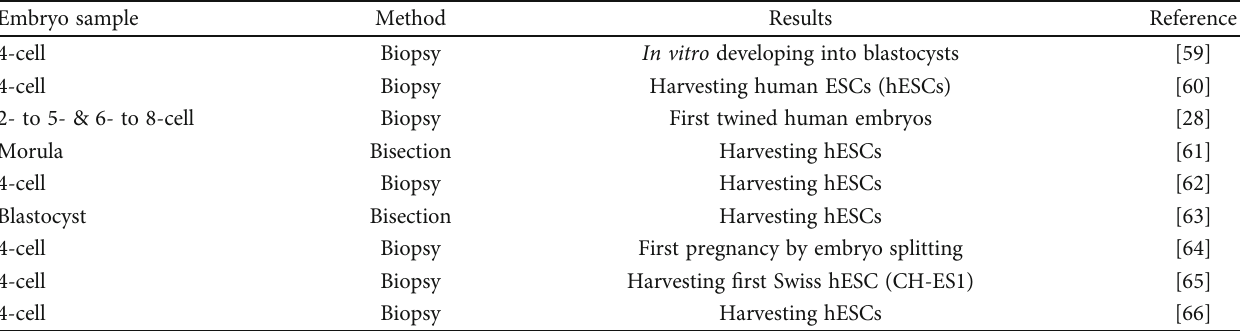
Table 4: Human embryo splitting.